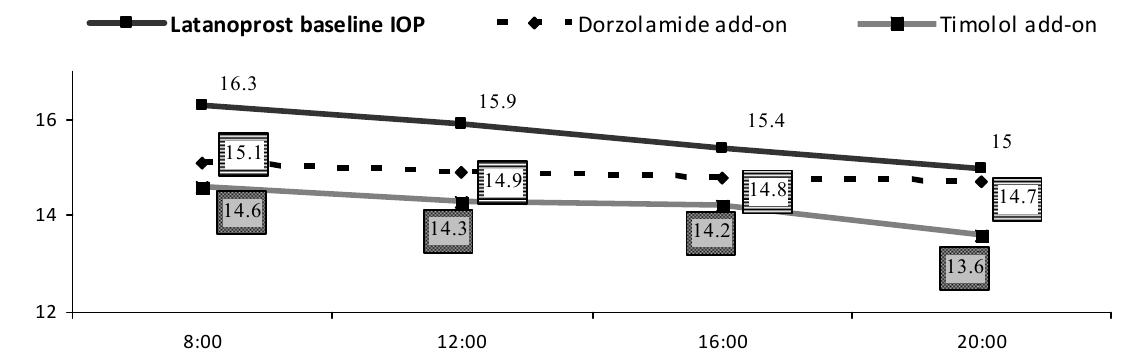
Figure 1. IOP diurnal fluctuations [mmHg].